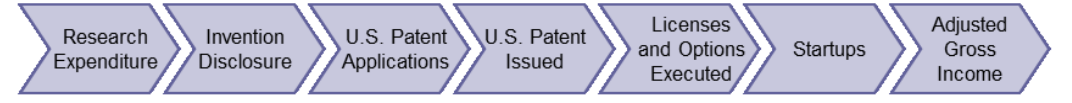
Figure 1. Commercialization pipeline. Each step in this pipeline corresponds to a metric in the AUTM survey. We use the health of the pipeline as a proxy for the overall health of the U.S. technology transfer